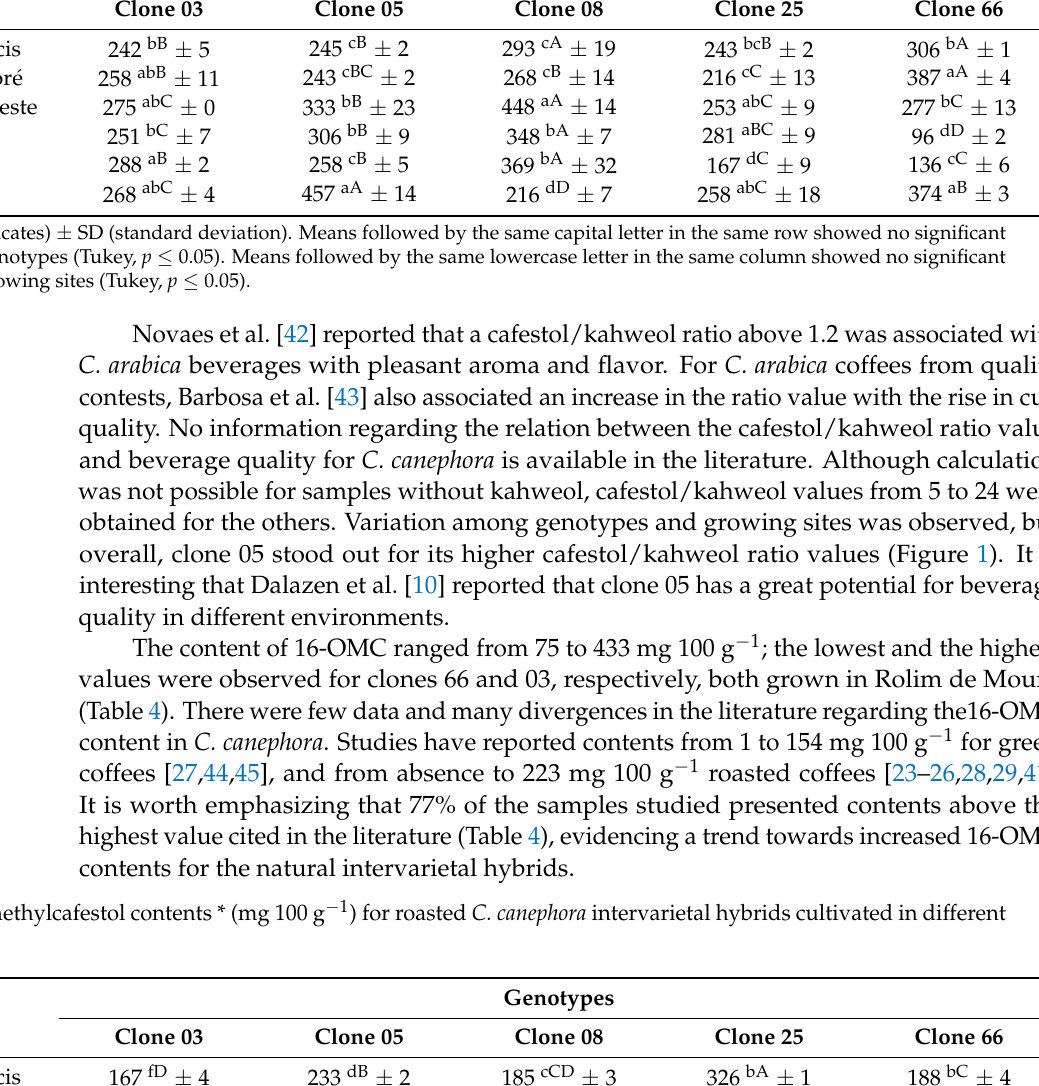
Table 3. Cafestol contents * (mg 100 g − 1 ) for roasted C. canephora intervarietal hybrids cultivated in different growing sites. Growing Sites